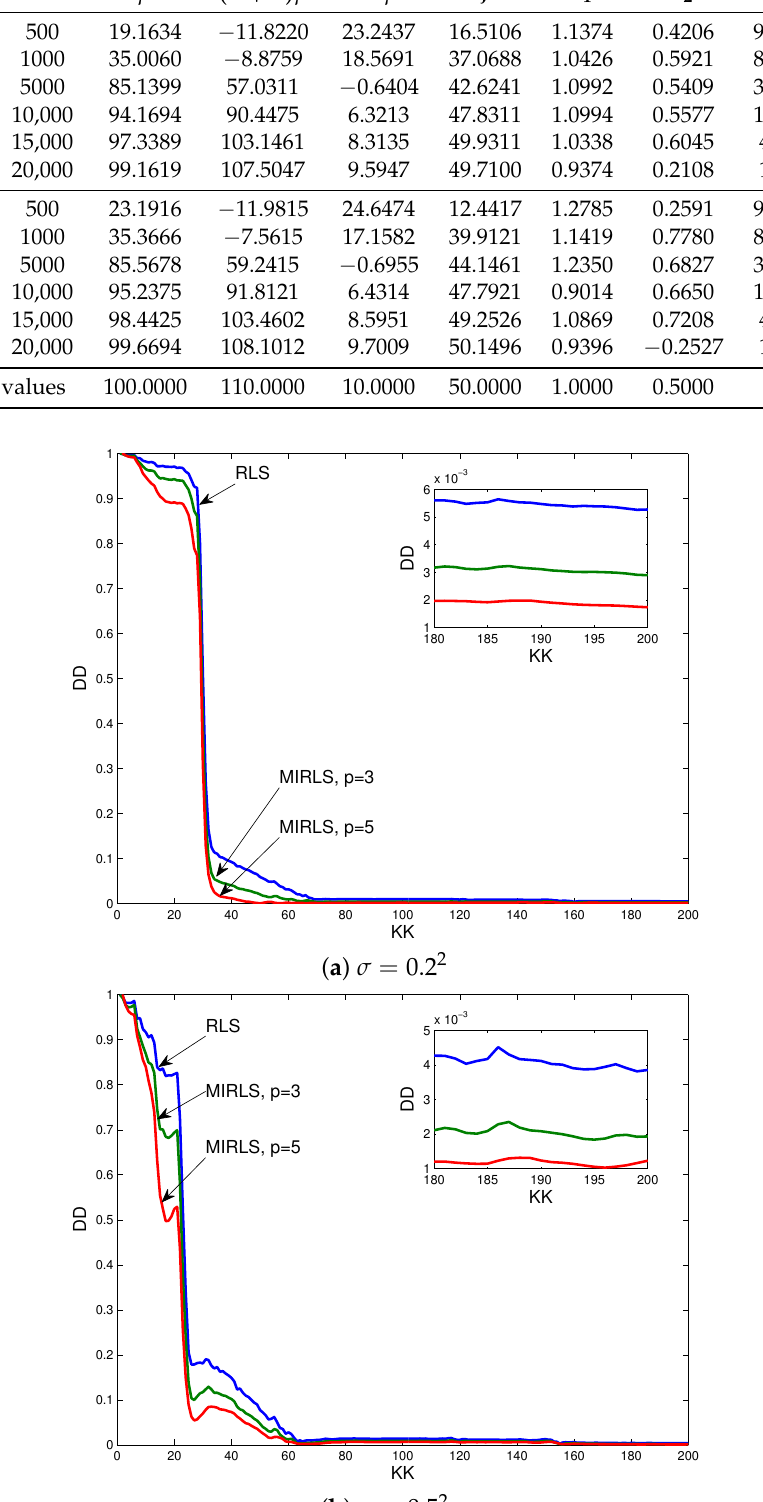
Figure 2. Parameter estimation errors δ versus k using RLS and